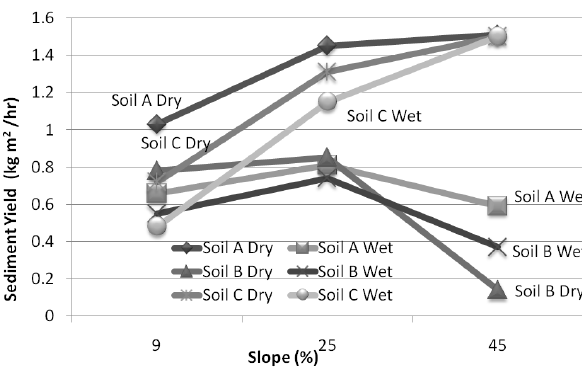
Fig. 2. Effect of the different levels of slope steepness on splash for Figure 2 Effect of the different levels of slope steepness on splash for the three soils at two levels the three soils at two levels of initial moisture content. 5 of initial moisture content.